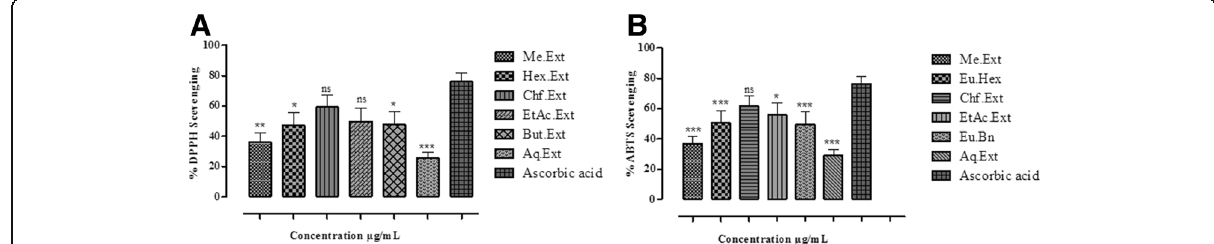
Fig. 3 a % DPPH b ABTS Scavenging activity of Me-Ext and subsequent fractions of E. umbellata fruit at various concentrations. The data is represented as Mean ± SEM, n = 3. Values are significantly different as compared to positive control (* P < 0.05, ** P < 0.01, *** P < 0.001)